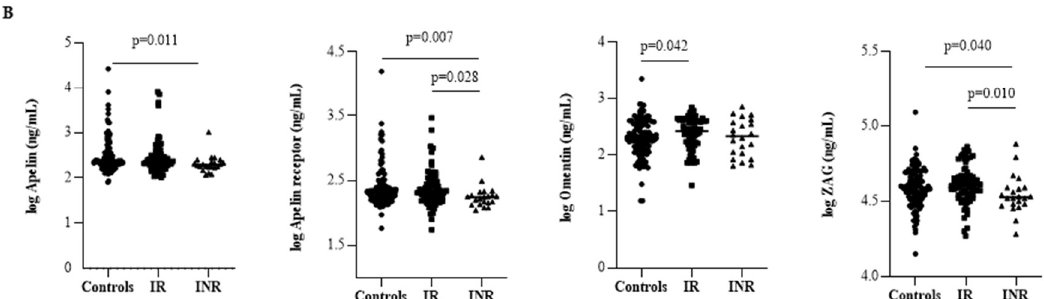
Figure 3. Follow-up circulating adipokine concentrations. Circulating apelin, APJ, omentin, and ZAG concentrations at ( A ) 48 weeks and ( B ) 144 weeks after ART in cases (IRs ( n = 77) and INRs ( n = 22)) compared to controls ( n = 120). p -value indicates significant differences among groups by nonparametric Mann–Whitney test.